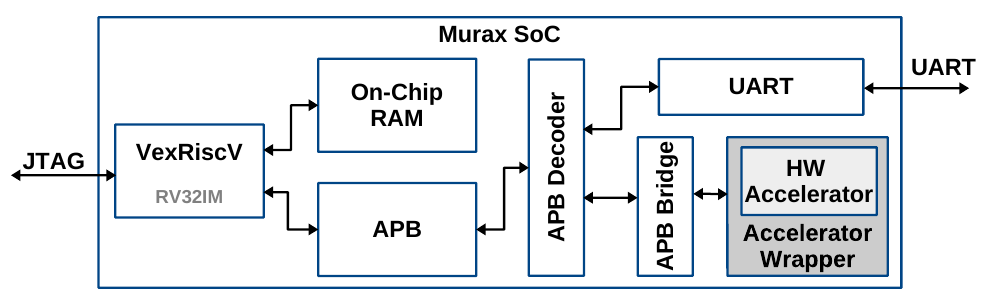
Figure 6: Schematic diagram of the Murax SoC. Hardware accelerators are connected to the APB. Details of the hardware accelerators are shown in Figure 8.